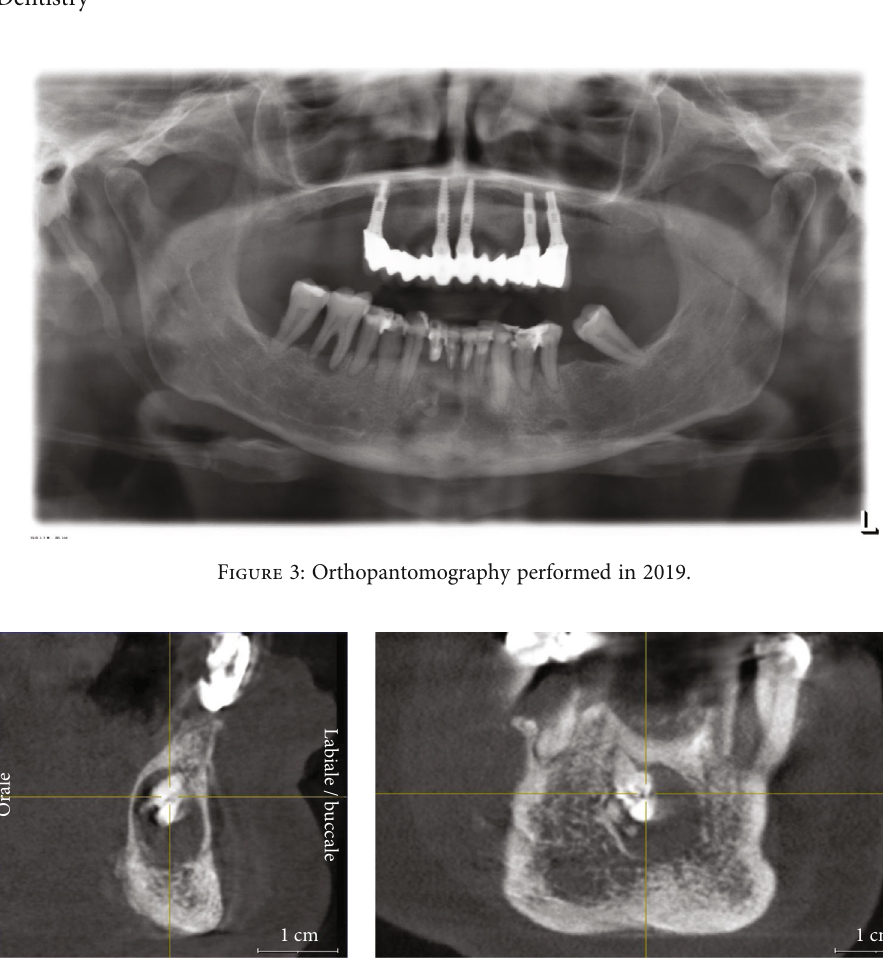
Figure 4: CBCT scan performed in 2020, showing the enlargement of the lesion compared to the fi rst CBCT scan.